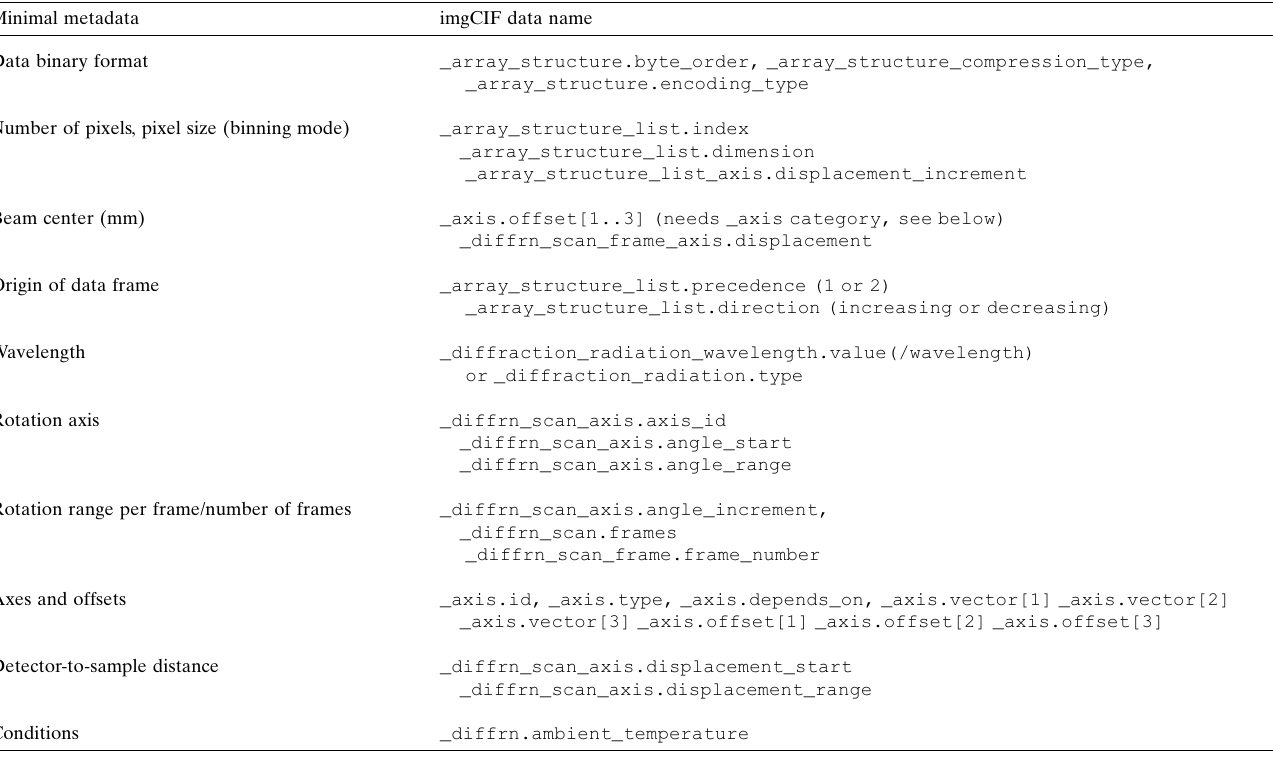
Table 1 Core metadata list and their data names in